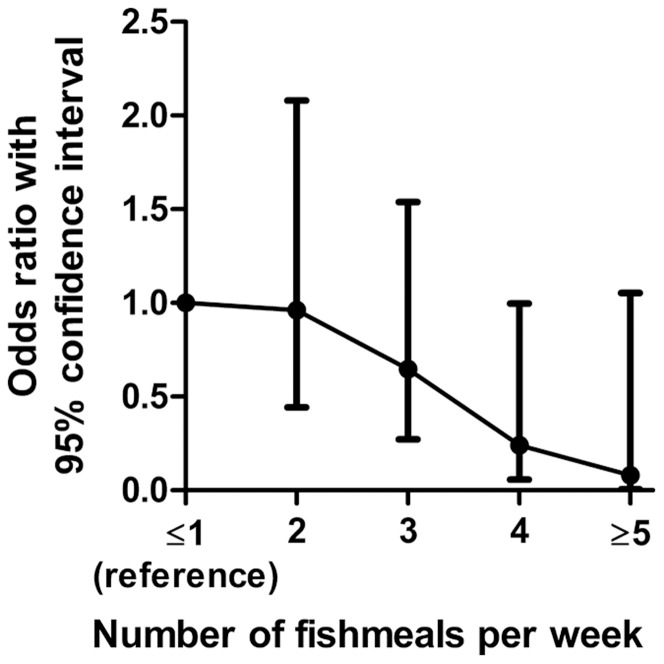
Decreasing riska of ESBL-positive urinary tract infection with increasing number of fishmeals per weekb.
aControlling for the variables: Travelling to Asia, Middle east or Africa, Use of fluoroquinolones the past 90 days, Use of β-lactams except mecillinam the past 90 days, Diabetes mellitus,Recreational freshwater swim past year and age. bReference category: eating ≤1 fishmeal per week.